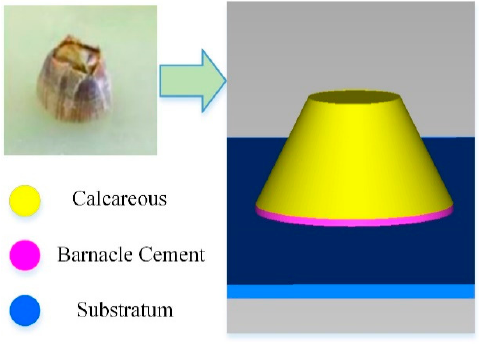
Figure 3. The cross-section of a barnacle on a foreign substratum.